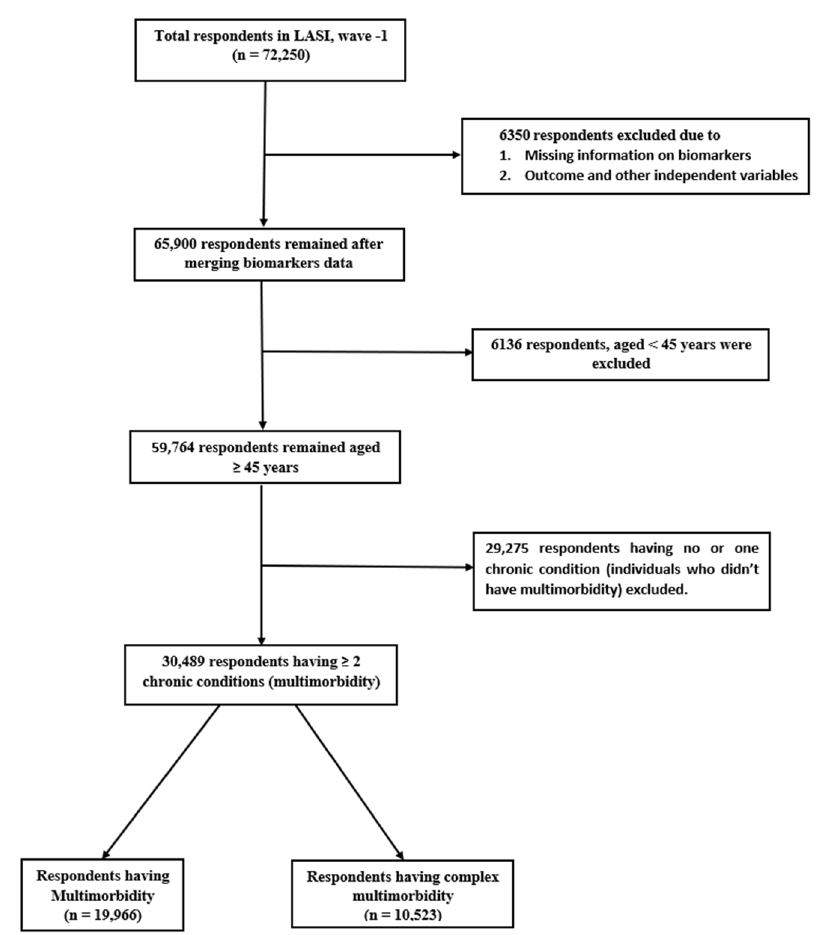
Figure 1. Selection of study population.